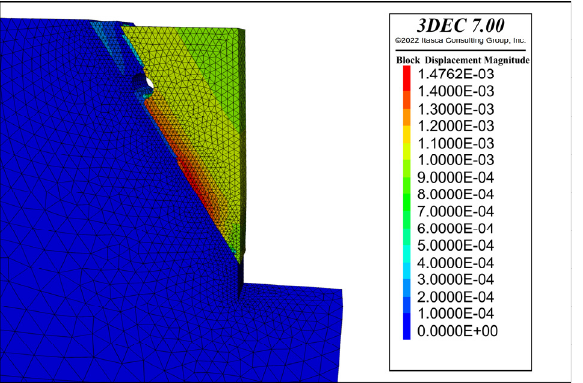
Figure 5. Pile diameter of 0.8 m, 2.0 times pile spacing, cantilever pile support (three retaining piles).